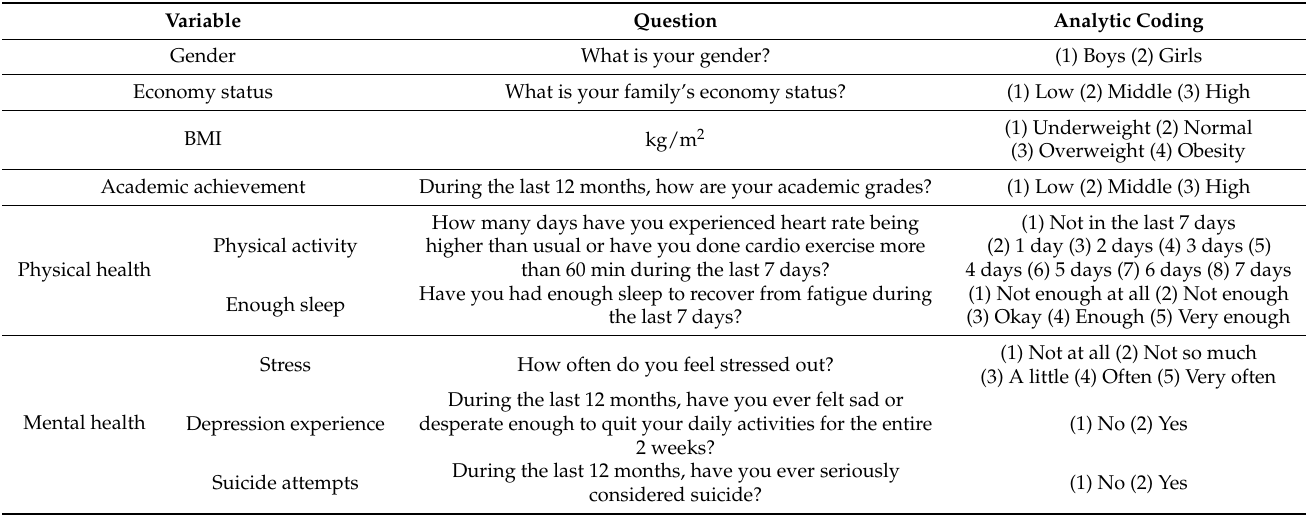
Table 1. Question and analytic coding for independent